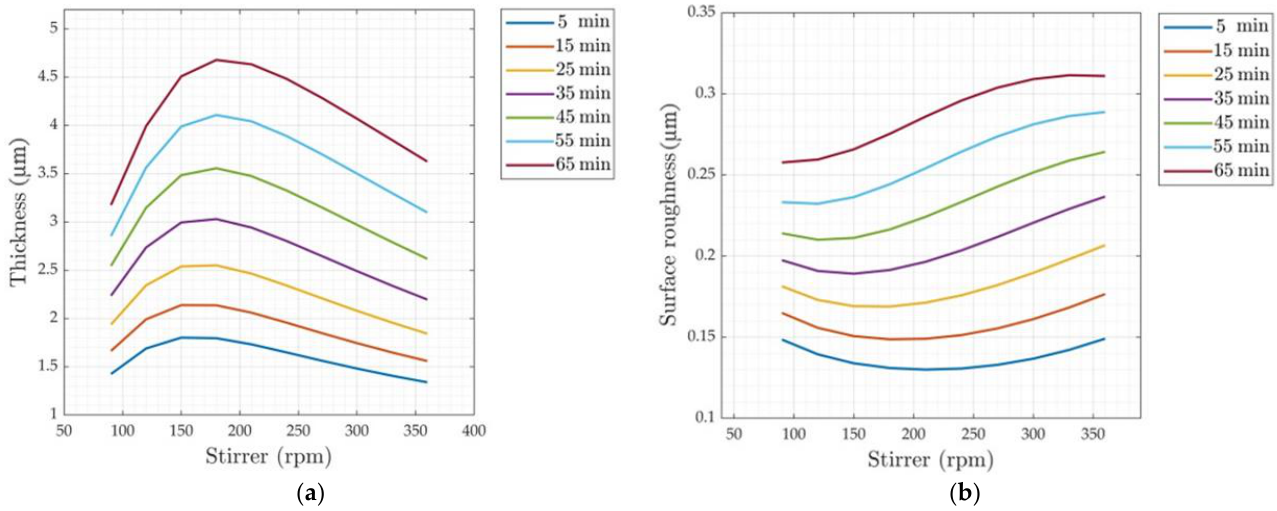
Figure 8. The results of the NN prediction on the effect of the stirring speed at the current density of 20 mA/cm 2 , beam width of 50 μm , and RTD of 3, relative to ( a ) thickness of nickel coated layer; ( b ) surface roughness of nickel coated layer. ( b ) surface roughness of nickel coated